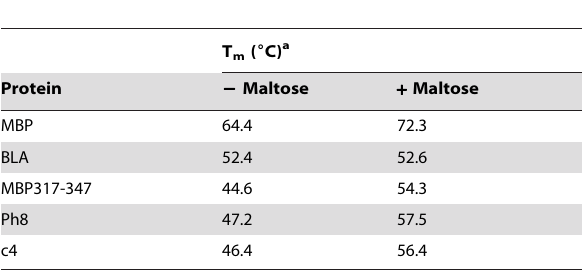
Table 4. Melting temperatures of